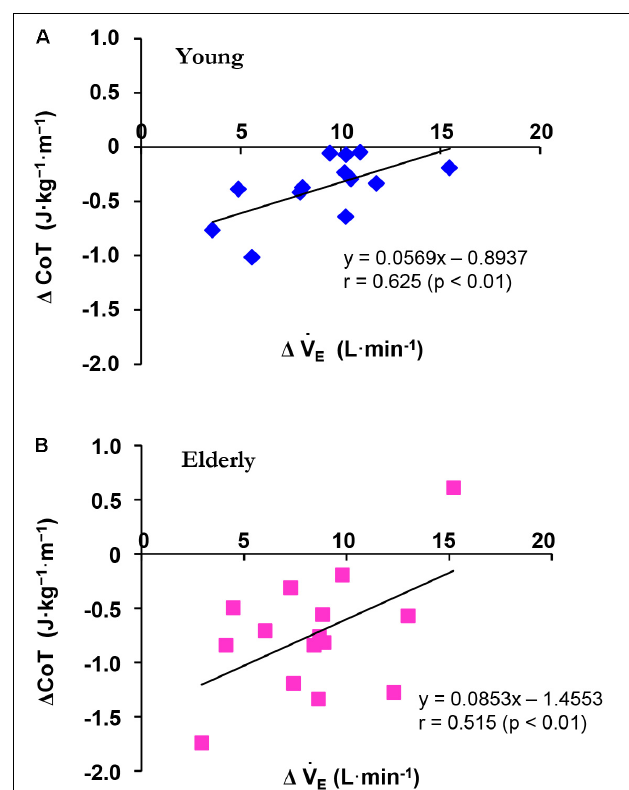
FIGURE 1 | Relationship between the (cid:49) CoT and (cid:49) ˙V E during constant walking in the young (YG, A ) and elderly (ELD, B ) subjects. Note that the (cid:49) CoT was significantly related to (cid:49) ˙V E in both the YG ( blue ) and ELD ( red ) groups. The regression line between the (cid:49) CoT and (cid:49) ˙V E was significant in both the YG ( r = 0.625, p < 0.01) and ELD ( r = 0.515, p < 0.01)